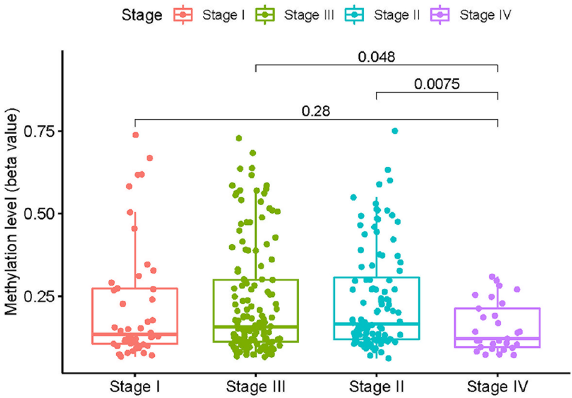
Figure 8. DNA methylation level of LOX is corelated with tumor